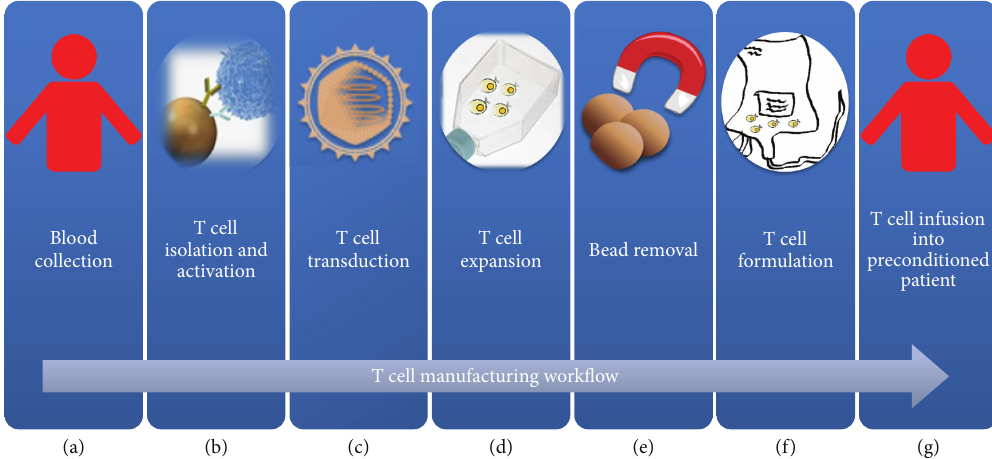
Figure 3: Example of manufacturing and delivery pipeline of CAR T cell therapies [7, 8]. Peripheral blood mononuclear cells (PBMCs) are harvested from the patient (or a T cell donor) (a) and transferred to a good manufacturing practice (GMP) facility, where the T cells are isolated and activated in the presence of magnetic beads conjugated with CD3 and CD28 antibodies (b) and subsequently genetically engineered by viral transduction to express the CAR (c). The activated T cells are expanded ex vivo for a period, typically 10–14 days, to reach a therapeutic relevant number (d) before magnetic bead removal (e) and formulation, either for freezing or for adoptive transfer (f). The patient undergoes a conditional chemotherapy prior to infusion of the CAR T cells